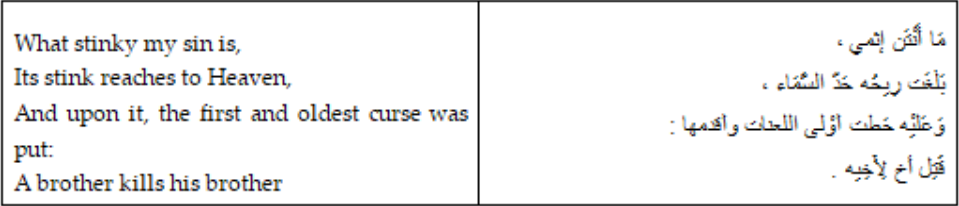
Figure 6. Claudius’s last words in the play. The text is transcribed from a video of the production posted on YouTube (See El-Basha